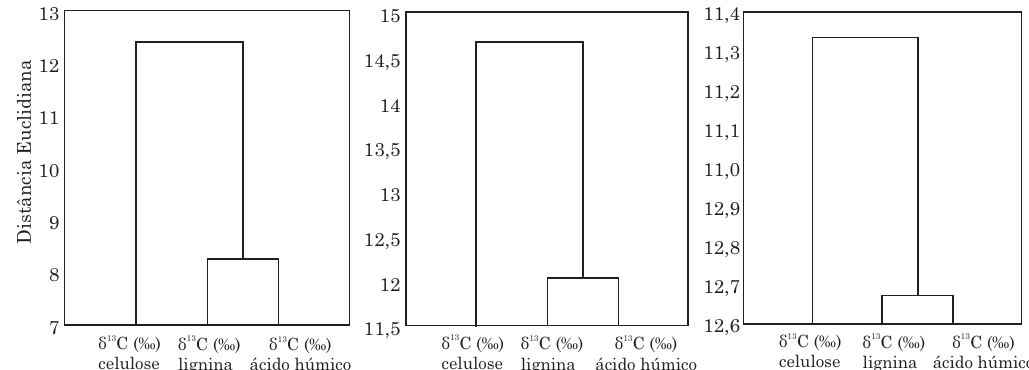
Figura 5. Dendrograma de conglomeração dos teores de ä 13 C (‰) da lignina e celulose da MOS, em relação a humina, ácidos húmicos e ácidos